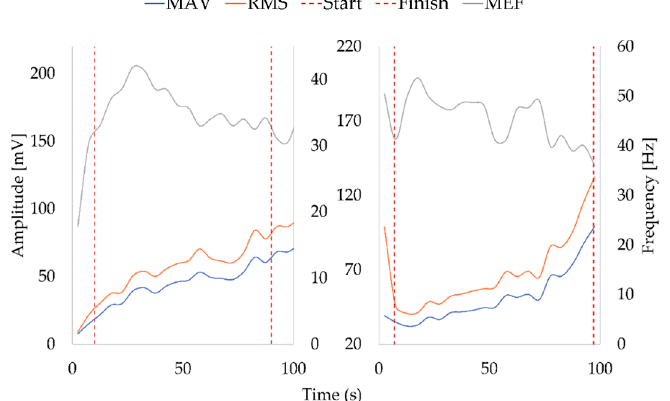
Figure 6. Two time cropped examples of the root mean square (RMS, left vertical axis), mean absolute value (MAV, left vertical axis) and mean frequency (MNF, right vertical axis) across time (s). The example on the left comes from a female who is 24 years old, exercises 3 h a week and has a BMI of 24, and the example on the right comes from a male who is 23 years old, exercises 3 h a week and has a BMI of 23.6.